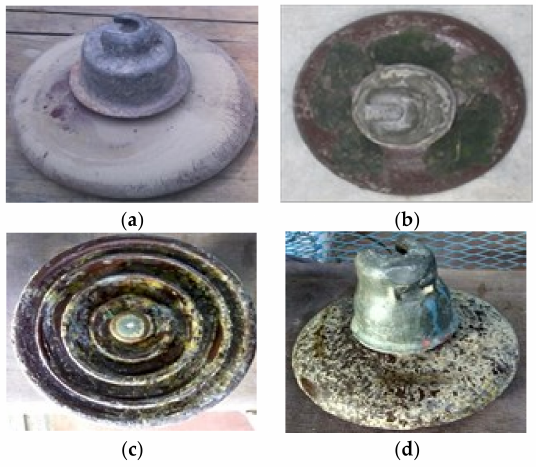
Figure 2. Prepared polluted samples. ( a ) Urea and dust; ( b ) algae; ( c ) fungus—bottom view; ( d ) fungus—top